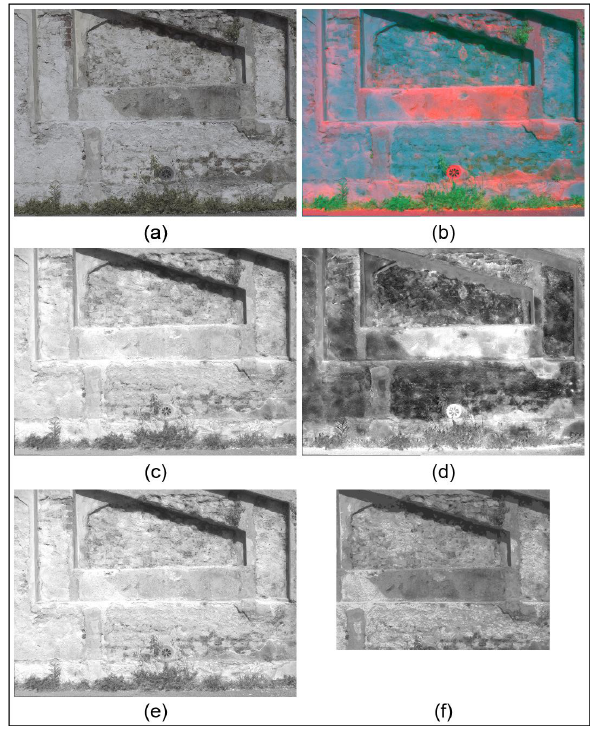
Figure 6. Castello del Valentino riverside façade multiband results: (a) cropped VIS image; (b) TIR-NIR-red false-color composite; (c,d) principal component analysis–first and second component; (e) Fourier transform; (f) quantized image.